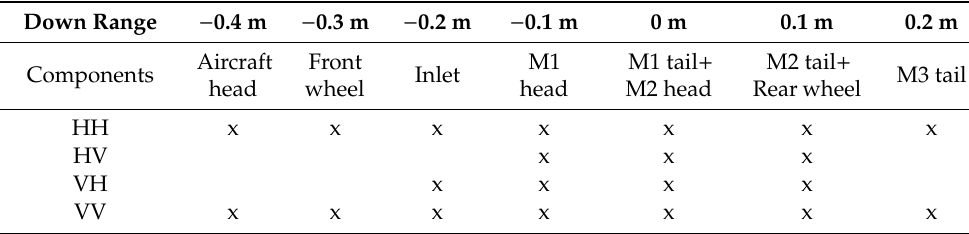
Figure 14. T omographic image slices along the downrange : ( a ) HH, ( b ) HV, ( c ) VH., and ( d ) VV. Figure 14. Tomographic image slices along the downrange: ( a ) HH, ( b ) HV, ( c ) VH, and ( d ) VV. Table 5. Components of the aircraft in tomographic image Table 5. Components of the aircraft in tomographic image slices.